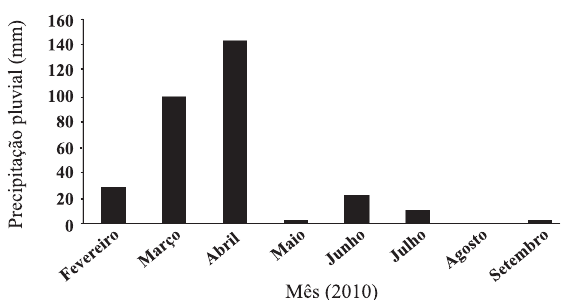
figura 1. pluviometria durante o ensaio experi- mental na Estação Experimental do instituto agronômico de pernambuco, em